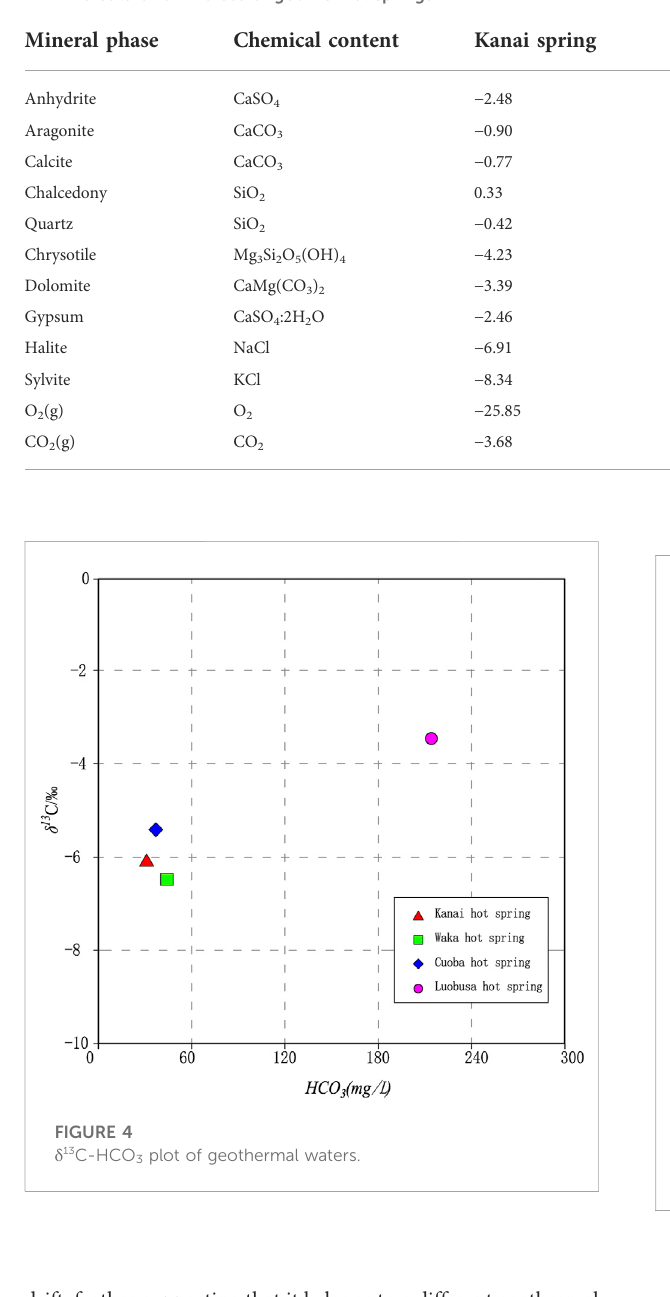
TABLE 3 Saturation indices of geothermal springs.